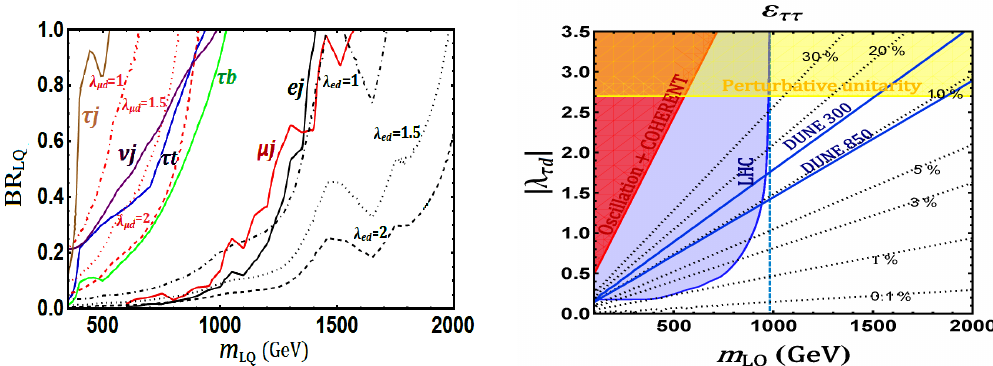
Figure 7.3: (a) LHC constraints on scalar LQ from pair and single production. (b) (cid:34) ττ prediction compared with various constraints. The shaded regions are excluded. See text and Ref. [ 151 ] for more details.